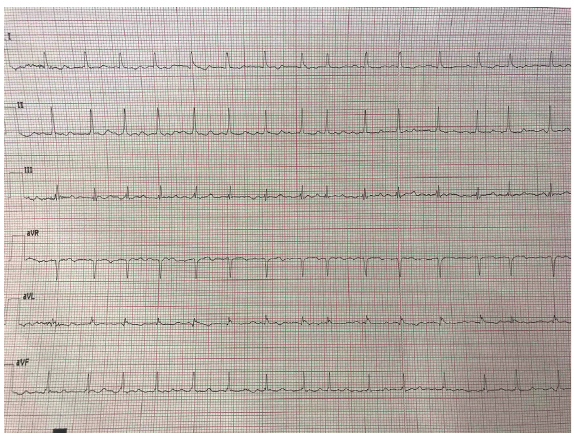
Figure 1: ECG showing atrial fibrillation.